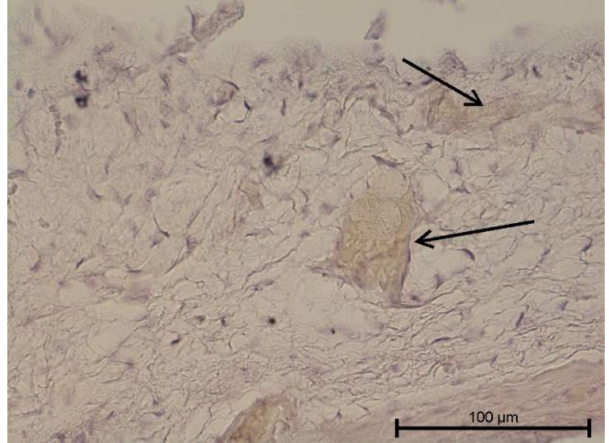
Figure 11. Light microscope image. Healthy tooth. Anti-Collagen IV—positive (black arrow). Mag. 400 × .